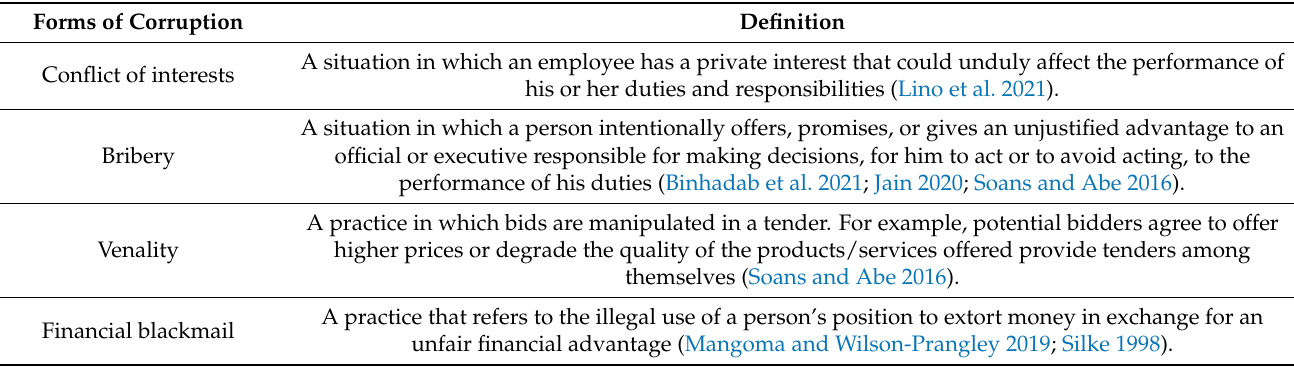
Figure 2. Corruption as a form of fraud. Source: Scopus/Biblioshiny. Table 1. Distinguishing corruption into forms.